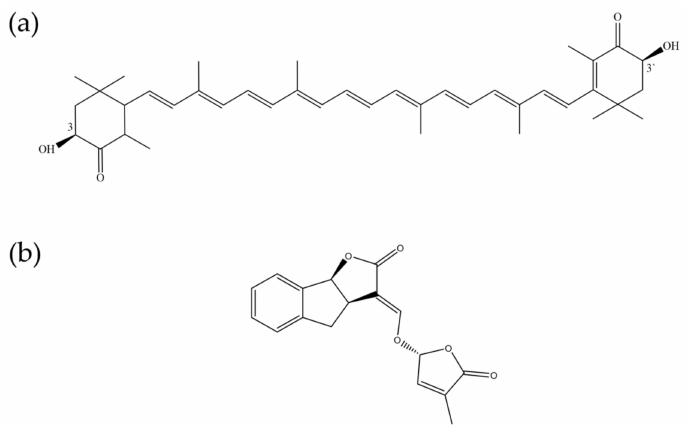
Figure 1. Chemical structures of astaxanthin ( a ) and strigolactone analog rac- GR24 ( b